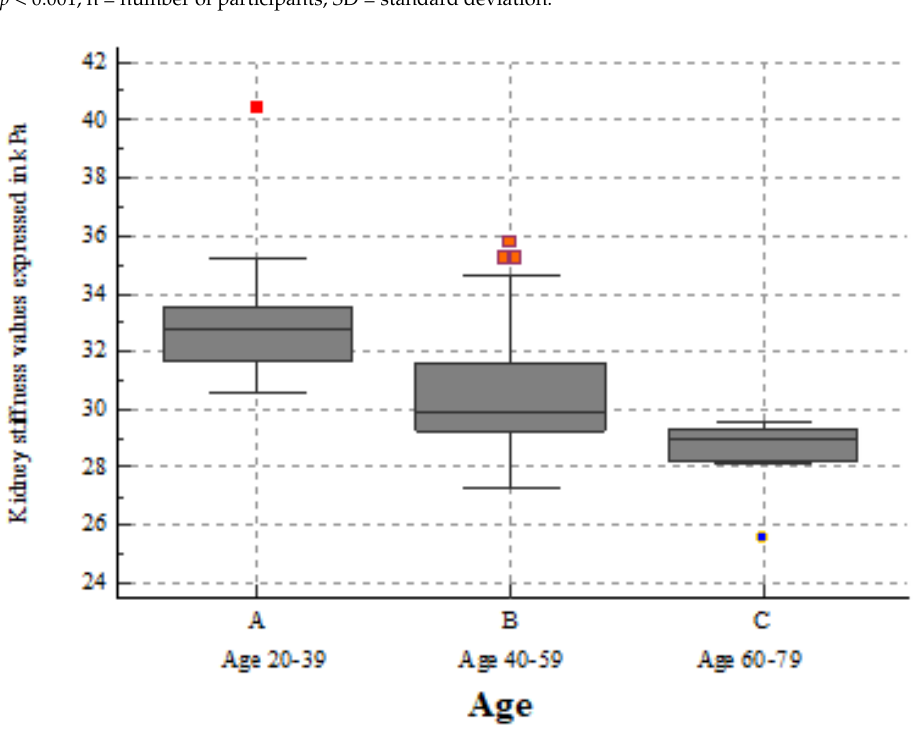
Figure 4. Box-and-whisker distribution plot showing 2D-SWE PLUS values across three different age subgroups. The 2D-SWE PLUS values decreased slightly with age progression. Table 3. The differences in variables among the three age sub-groups for Vi